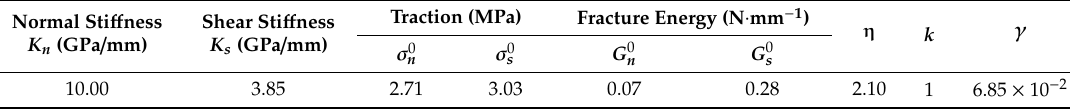
Table 3. Material parameters of FRP / concrete